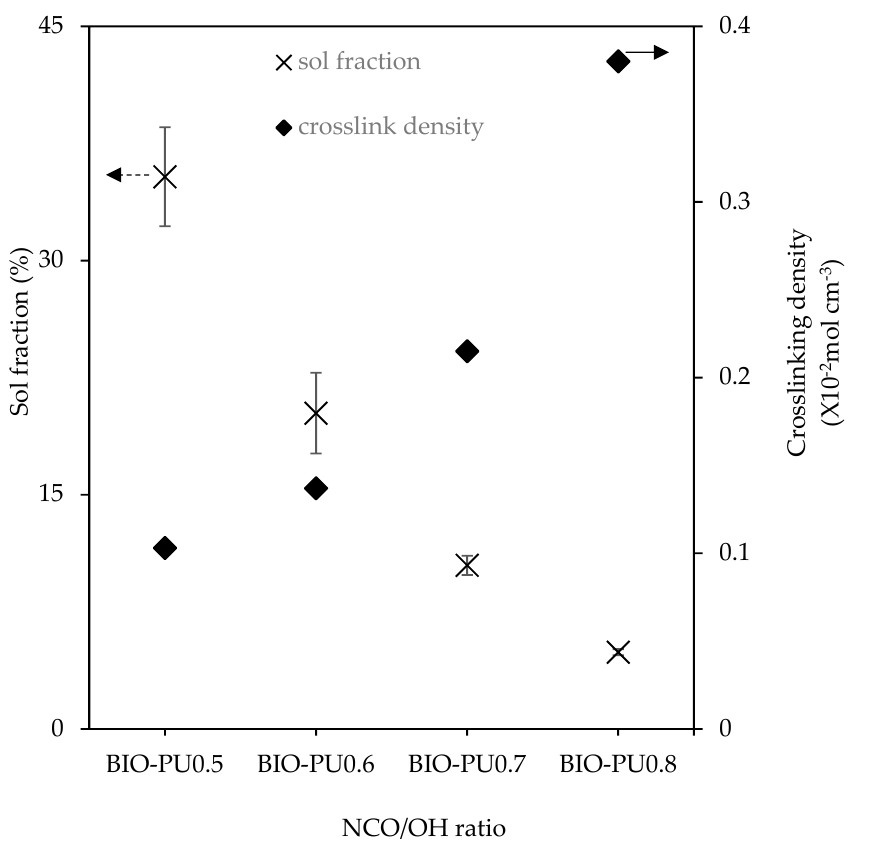
Figure 10. Crosslinking density and sol fraction of BIO-PU films at different NCO/OH ratios (n = 3).